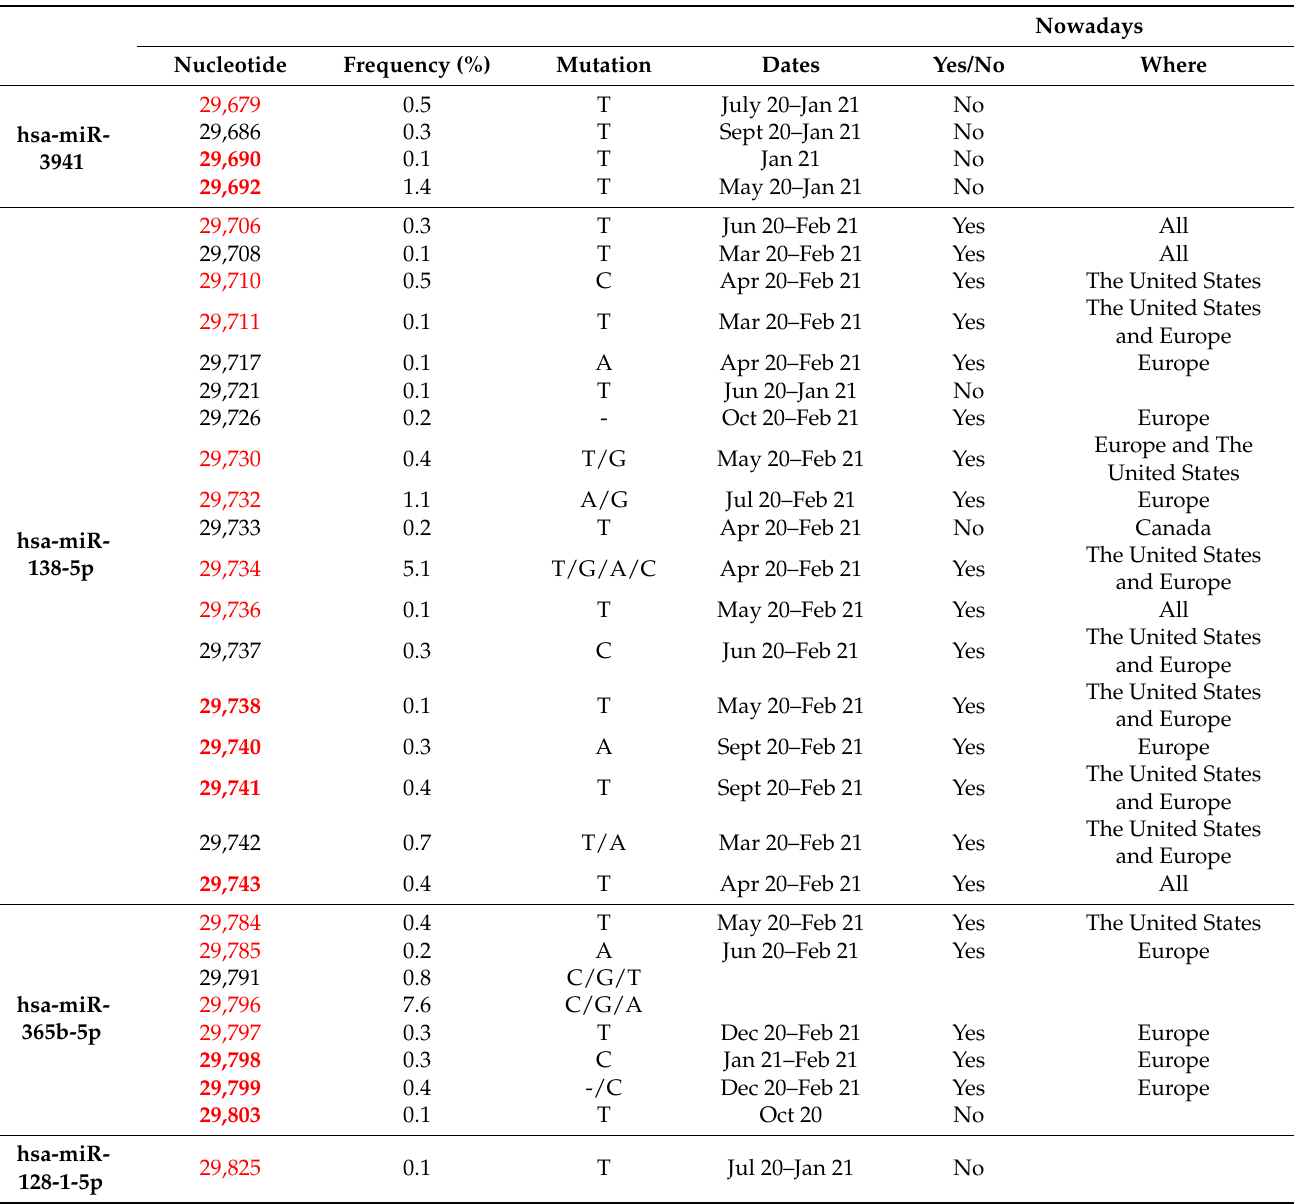
Table 2. Sequence variability in the binding sites of hsa-miR-3941, hsa-miR-138-5p, hsa-miR-365b-5p, and hsa-miR-128-1-5p. The table indicates the mutations and frequencies in each nucleotide of SARS-CoV-2 3 (cid:48) -UTR. The analysis is restricted to the 3 (cid:48) -UTR sequence of the best binding sites for each microRNA according to the prediction algorithms. Mutations in nucleotides complementary to the microRNAs are represented in red, whereas those complementary to the seed region are marked in bold red. Data are extracted from COVID CG, accessed on 22 February 2021 (511,596 sequences analyzed). Nowadays Dates